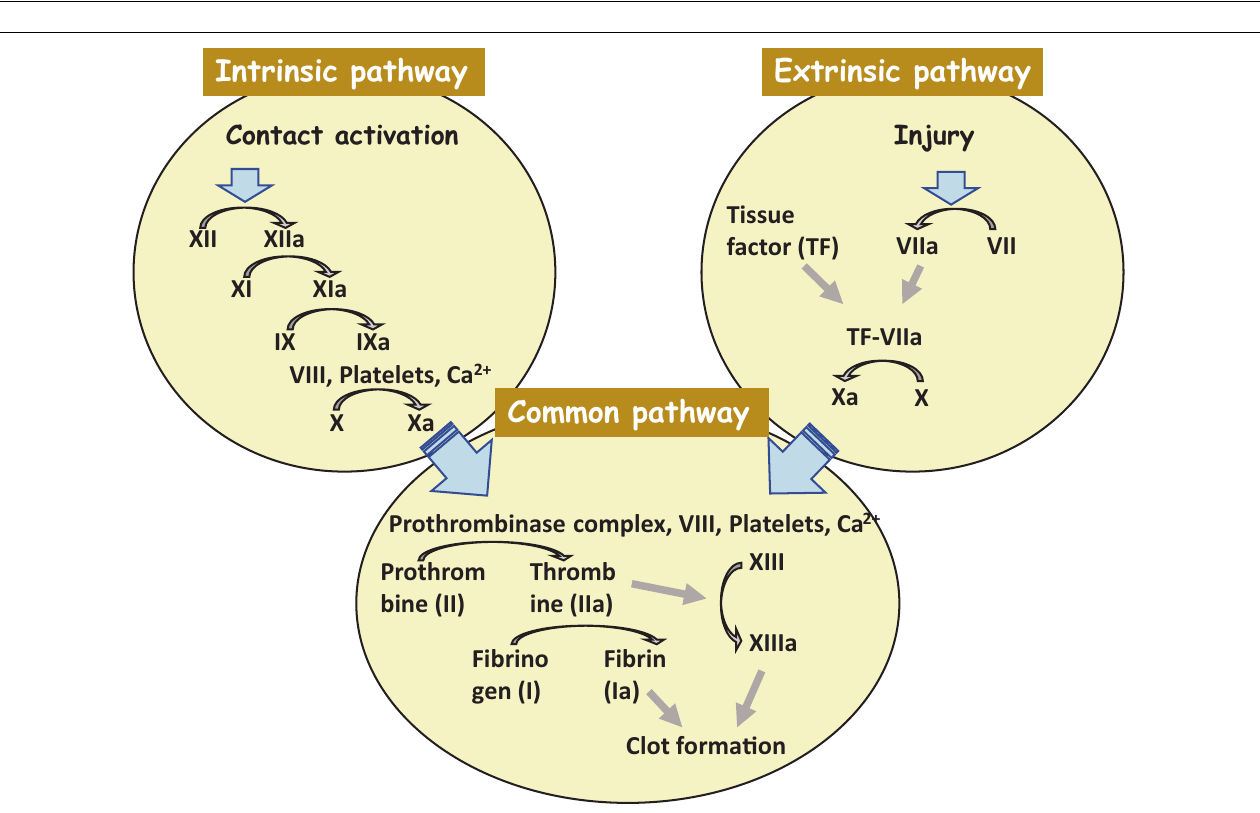
FIGURE 2 | A clot formation cascade. There are three steps of the clotting (coagulation) cascade: the intrinsic pathway (factors XII, XI, IX, and VIII), the extrinsic pathway (factor VII), and the common pathway. During clotting, cascade factor X may be activated by the extrinsic and intrinsic pathways. The common pathway consist of steps from the activation of factor X to the clot formation. Factors that are activated are shown with a lowercase